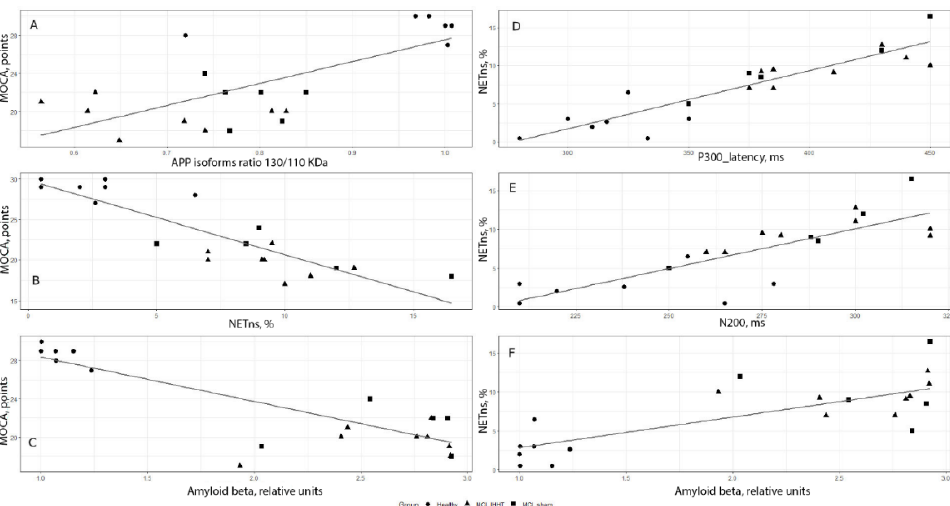
Figure 3. Correlation relationships between cognitive function indices and some circulating biomarkers of Alzheimer’s disease in all three groups of patients with mild cognitive impairments at pre-baseline. Left column: ( A ) Montreal Cognitive Assessment (MoCA) score and amyloid precursor protein (APP) isoforms ratio 130/110 (r = 0.72, p < 0.05), ( B ) MoCA score and non-stimulated neutrophil extracellular traps (NETns) (r = −0.87, p < 0.01); ( C ) MoCA score and amyloid beta (Aβ) expression (r = −0.79, p = 0.02). Right column: ( D ) NETns and long latency cognitive event-related potential P300 (r = 0.90, p < 0.01); ( E ) NETns and long latency cognitive event-related potential N200 (r = 0.79, p = 0.02), ( F ) NETns and A β expression (r = 0.81, p =